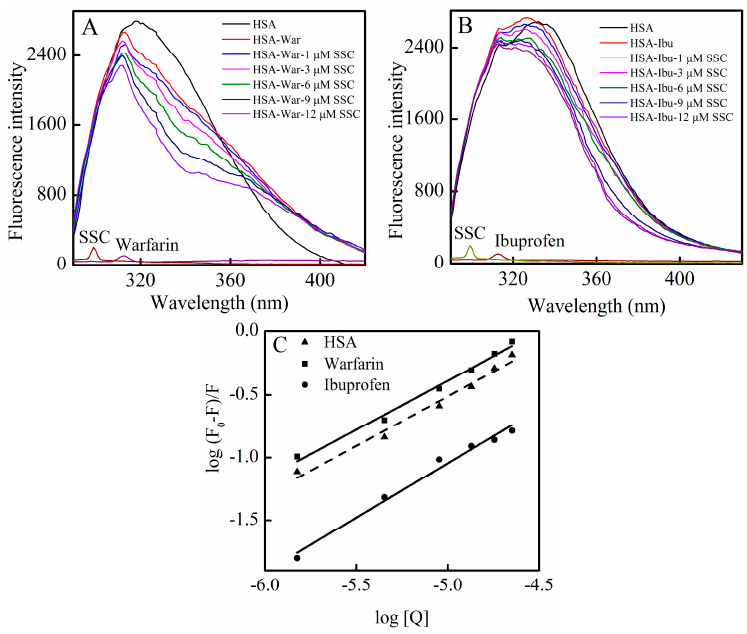
Figure 6. Effect of site marker probes on the SSC-HSA system. The experiment was carried out at C HSA = 2 μ M, T = 26 °C, pH = 7.4, and λ ex = 280 nm. ( A ) C warfarin = 0.025 M; ( B ) C ibuprofen = 0.25 M; ( C ) Double-reciprocal plots for log (F 0 − F)/F vs. log [Q]; [Q], C SSC = 0, 1, 3, 6, 9, and 12 μ M. War, Warfarin; Ibu, Ibuprofen.